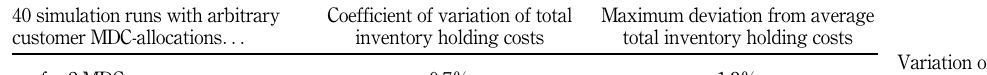
Table III. Variation of inventory holding costs for different